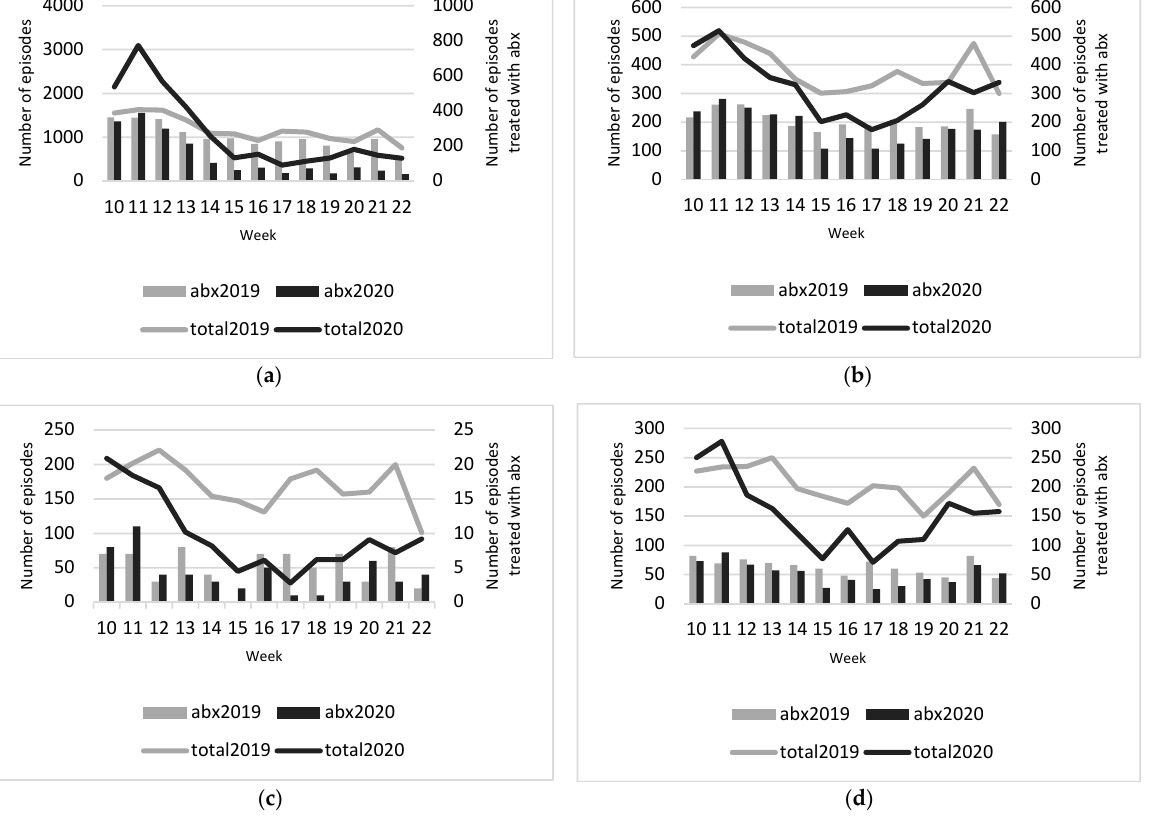
Figure 1. Total number of infectious disease episodes and episodes with antibiotic prescription in 2019 and 2020, per week, ( a ) respiratory/ear infections, ( b ) urinary tract infection, ( c ) gastrointestinal infections, ( d ) skin infections. Abbreviations: Abx: antibiotics.